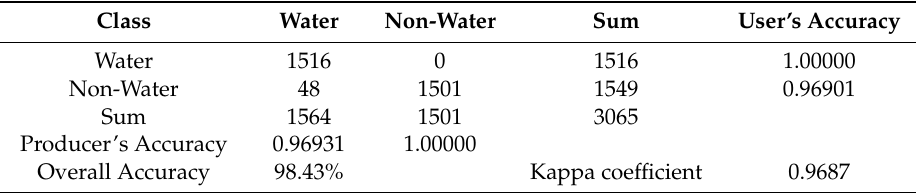
Table 7. Validation statistics of MNDWI for water body